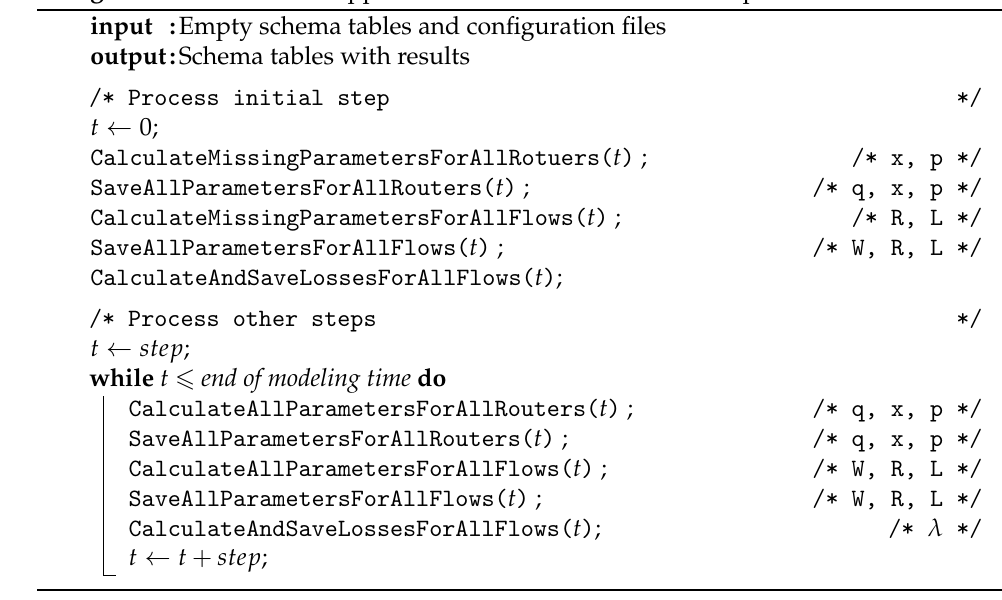
Algorithm 1: Fluid-flow approximation written as a database procedure